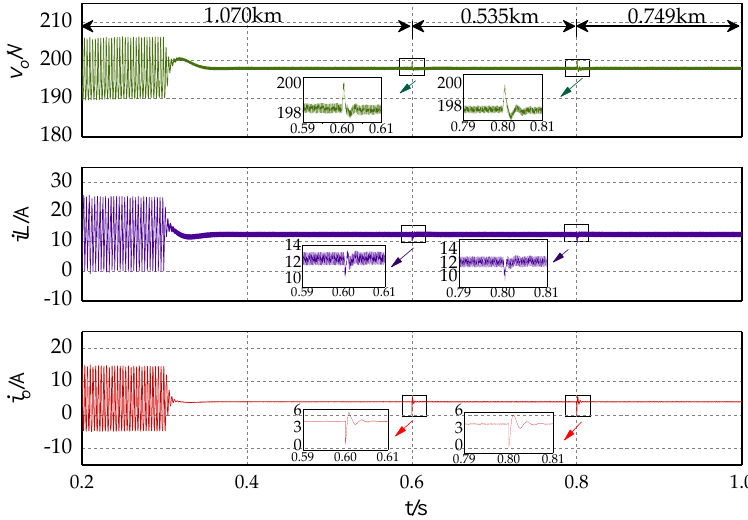
Figure 10. Simulation results of DC microgrid system with the change of line length.